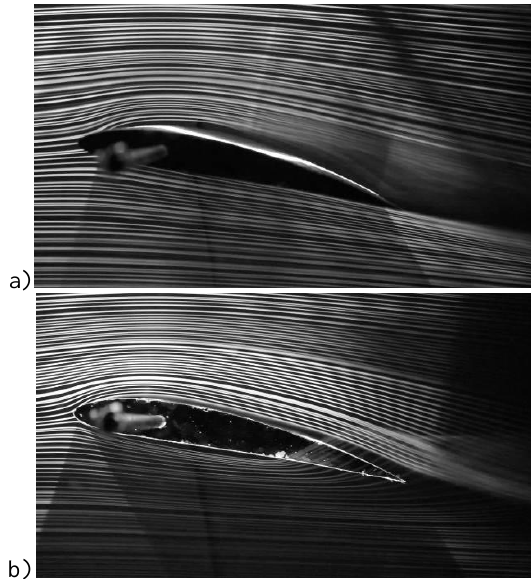
Fig . 6. At α=12º, smoke-wire photos for partial flexible wing at the plane of a) z/s=0.4 b) z/s=0.1 .